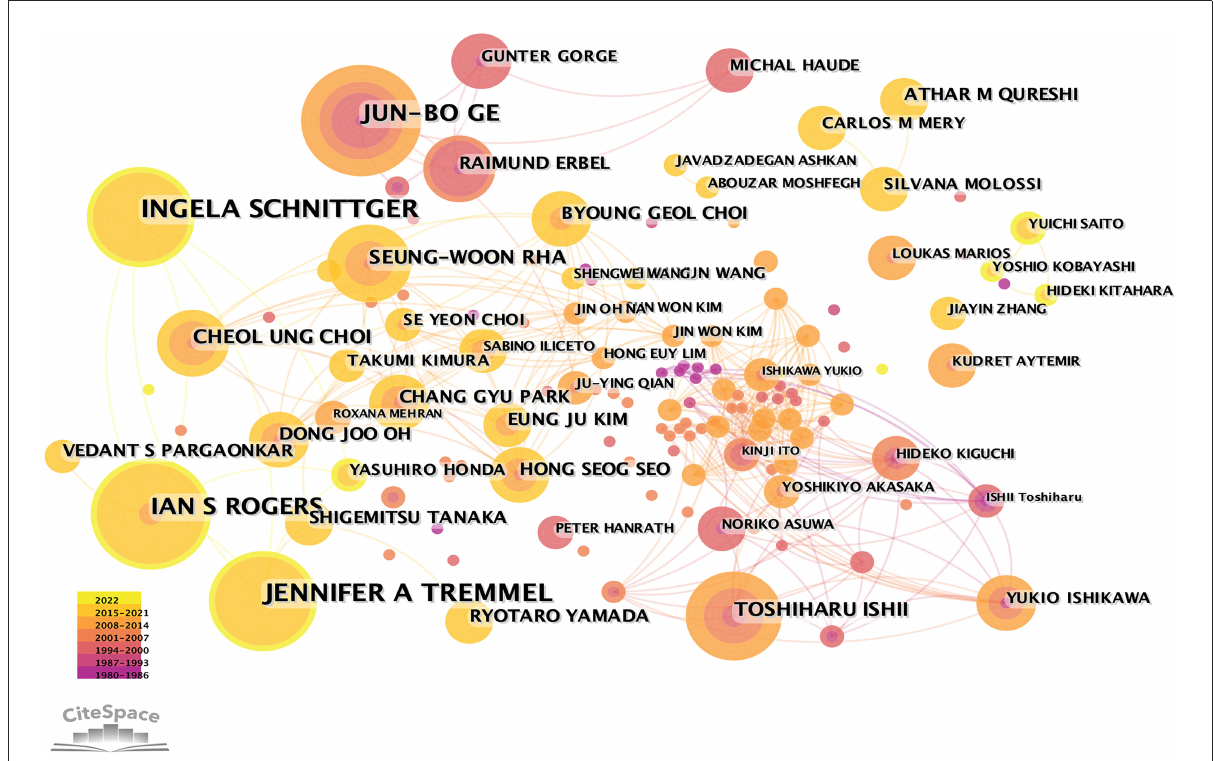
FIGURE3 Co-authorship among authors with more than three